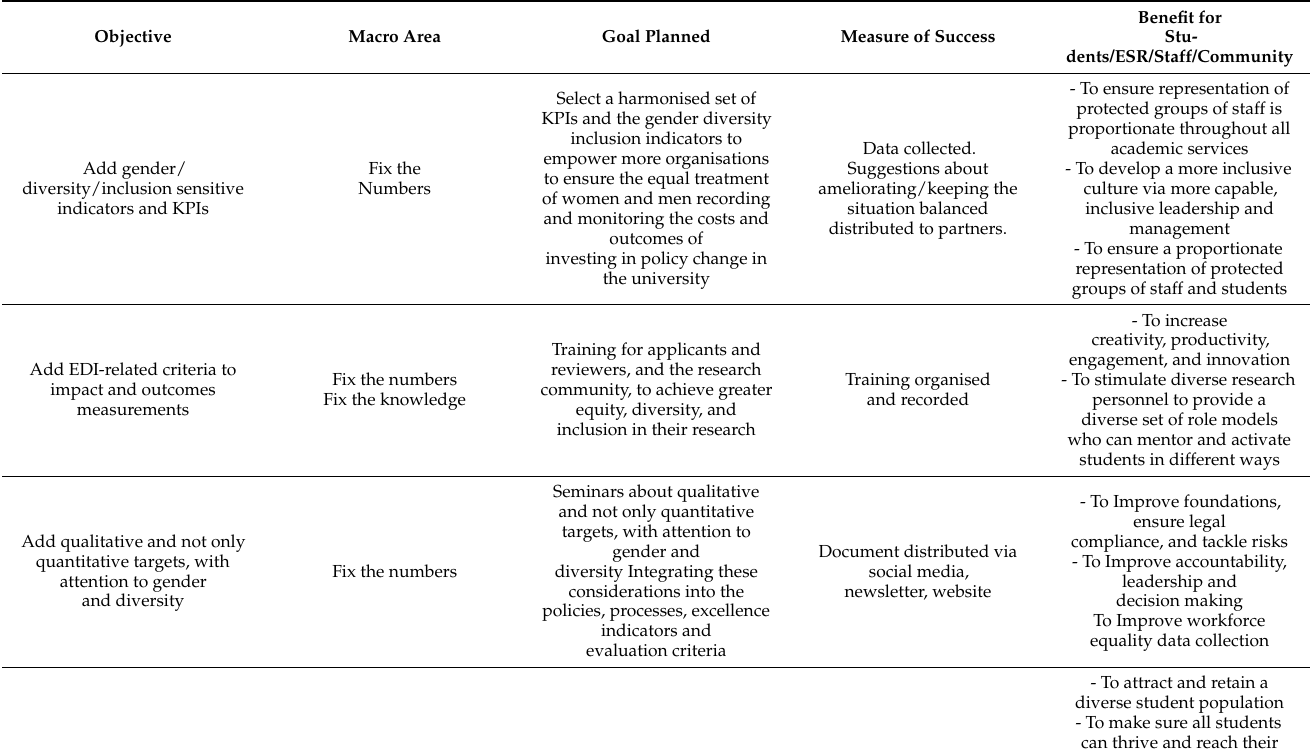
Table 3. EDI micro-actions of the ULYSSEUS